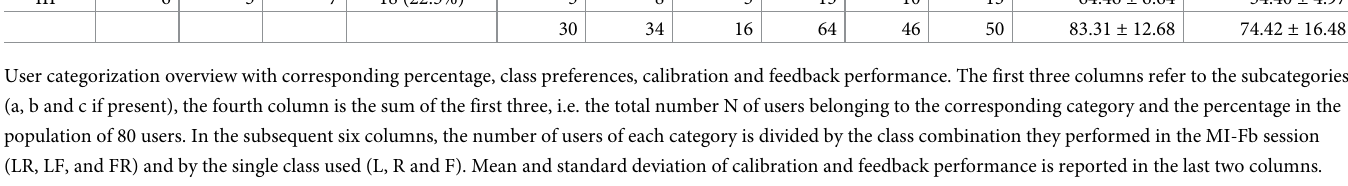
Table 1. User categorization overview. Cat.